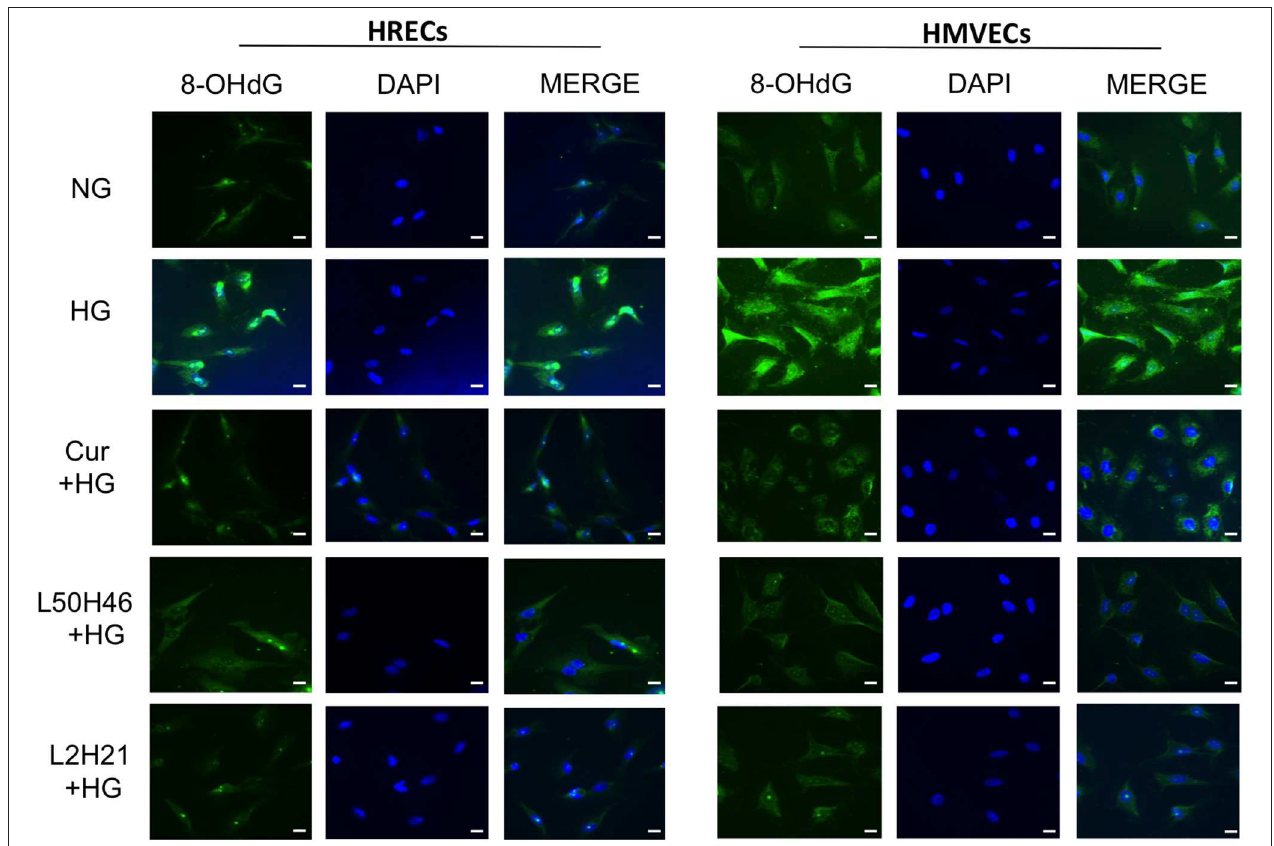
FIGURE 3 | Effect of curcumin and its analogs on high glucose-induced oxidative DNA damage in HRECs and HMVECs. 8-OHdG staining was used to assess high glucose-induced oxidative DNA damage. Cells were exposed to HG for 48h, with or without pre-treatment with curcumin or its analogs. The fluorescent images indicate that curcumin and its analogs decrease the level of glucose-induced oxidative DNA damage in both HRECs and HMVECs [original magnification at 20x; scale bar = 10 µ m, same magnification for all images; NG (normal glucose) = 5mM D-glucose; HG (high glucose) = 25mM D-glucose; green stain = 8-OHdG and blue (DAPI) stain = nuclear counterstain; images were merged, and each image is representative of at least 3 separate